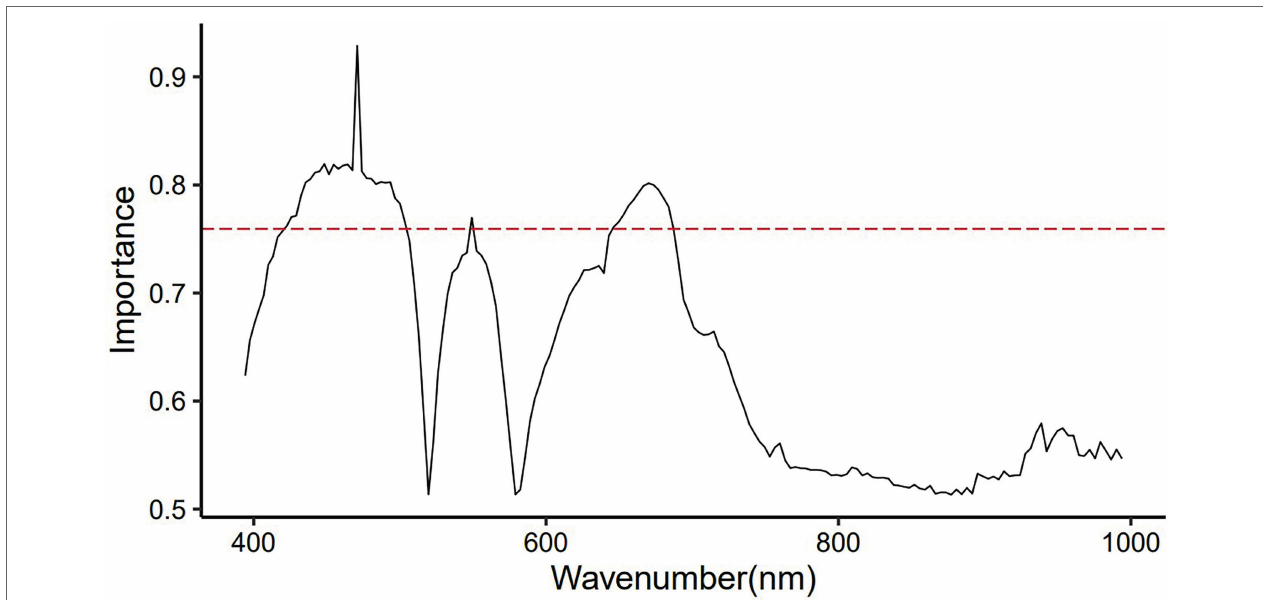
FIGURE 4 | Significant values of wavelengths for distinguishing raw VIS–NIR spectra of young and old leaves of Toona sinensis were found by the SVM model.